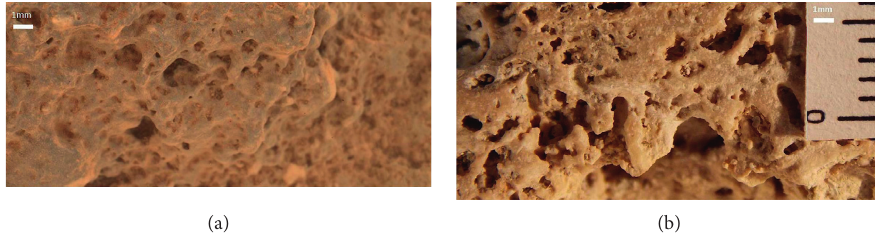
Figure 7: Microanalyses of a Martian stromatolite-like formation (a) photographed by the rover curiosity (sol 506) in gale crater compared with (b) a terrestrial stromatolite from Lagoa Salgada, Brazil. Voids, apertures, and highly organized microspherules and thrombolytic microfacies are common to both. Earthly cyanobacteria typically form voids, intertwined filaments, and layer deformation within stro- matolites (reproduced with permission from